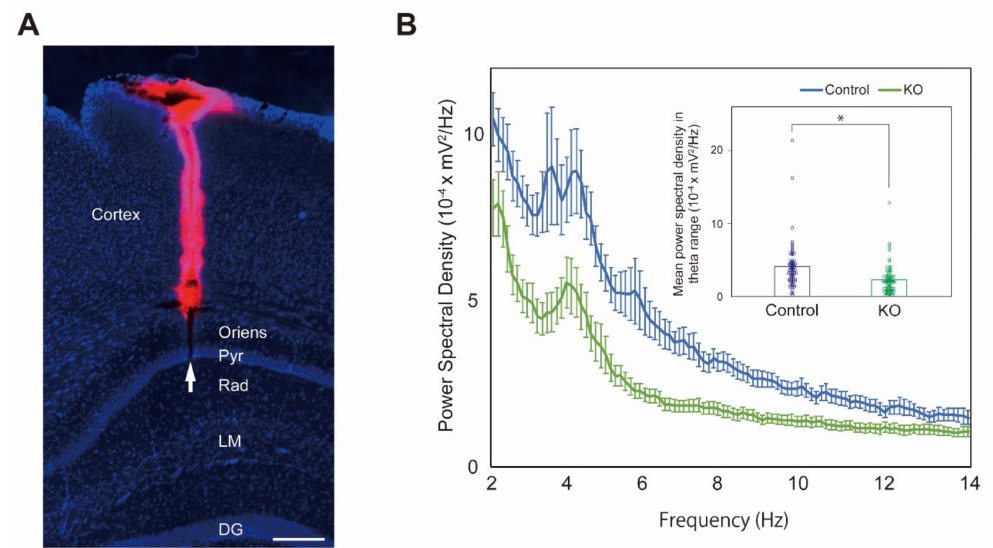
Figure 4. Results of electrophysiological recordings. ( A ) Probe track revealed by DiI staining in the hippocampus (scale bar: 200 µ m). Pyr, stratum pyramidale; Rad, stratum radiatum, LM, stratum lacunosum-moleculare; DG, dentate gyrus; Arrow, tip of the track of the silicon probe. ( B ) Power spectral density of LFP recorded in the CA1 pyramidal layer of controls and HCNP-pp KO mice. The theta range was defined as 3–12 Hz. HCNP-pp KO mice had significantly lower theta power than controls (Control: 4.11 ± 0.39 × 10 − 4 mV 2 / Hz, n = 69 trials vs HCNP-pp KO: 2.29 ± 0.24 × 10 − 4 mV 2 /